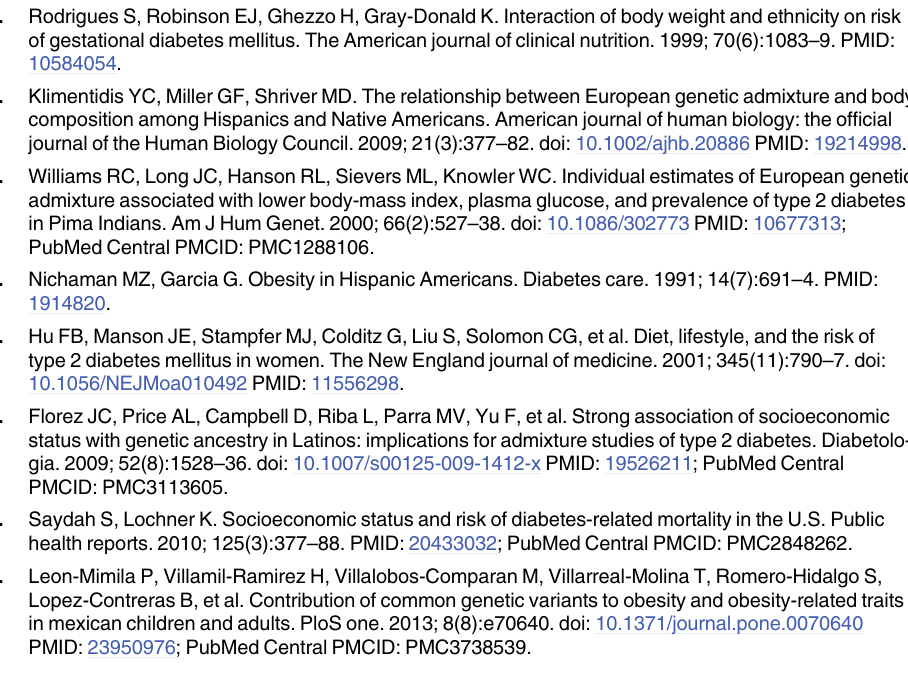
S1 Fig. Boxplot of Native American Ancestry by different dietary pattern groups. Dietary pattern 1 corresponds to “ Only Mexican food ” and pattern 5 corresponds to “ Only American food ” . S1 Table. Summary of ancestry informative markers. S2 Table. Proportion of individuals in the 1000 Genome Project corrected predicted by our admixture model under different ancestry fraction cutoffs. S3 Table. Response and predictor variables used for the regression